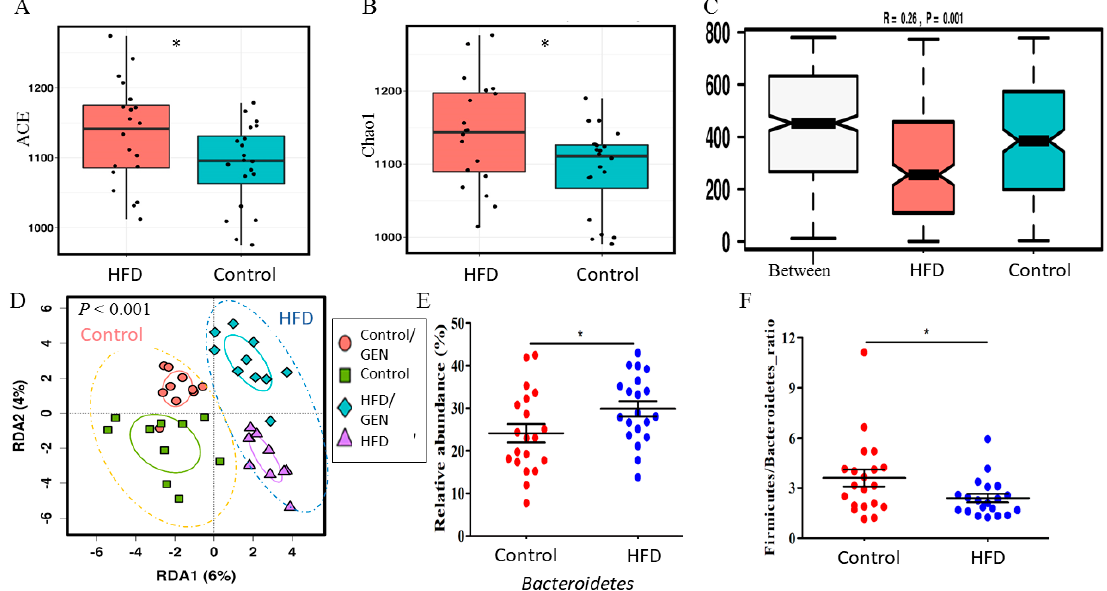
Figure 3. The maternal dietary status has a profound impact on the offspring microbiome. ( A ) The offspring of rat dams fed a maternal high-fat diet (HFD) had a significantly higher microbial richness, including Abundance-based Coverage Estimator (ACE), and ( B ) Chao1, compared with the offspring of dams fed a maternal control diet. The maternal dietary status also had a significant effect on beta diversity in the offspring, such as analysis of similarities (ANOSIM) based on Bray Curtis Dissimilarity ( C ) and redundancy analysis (RDA) based on weighted UniFrac metrics ( D ). ( E ) The abundance of the phylum Bacteroidetes was significantly increased in the HFD offspring as detected by ANCOM. ( F ) The Firmicutes to Bacteroidetes ratio was significantly reduced in HFD offspring. * p < 0.05.